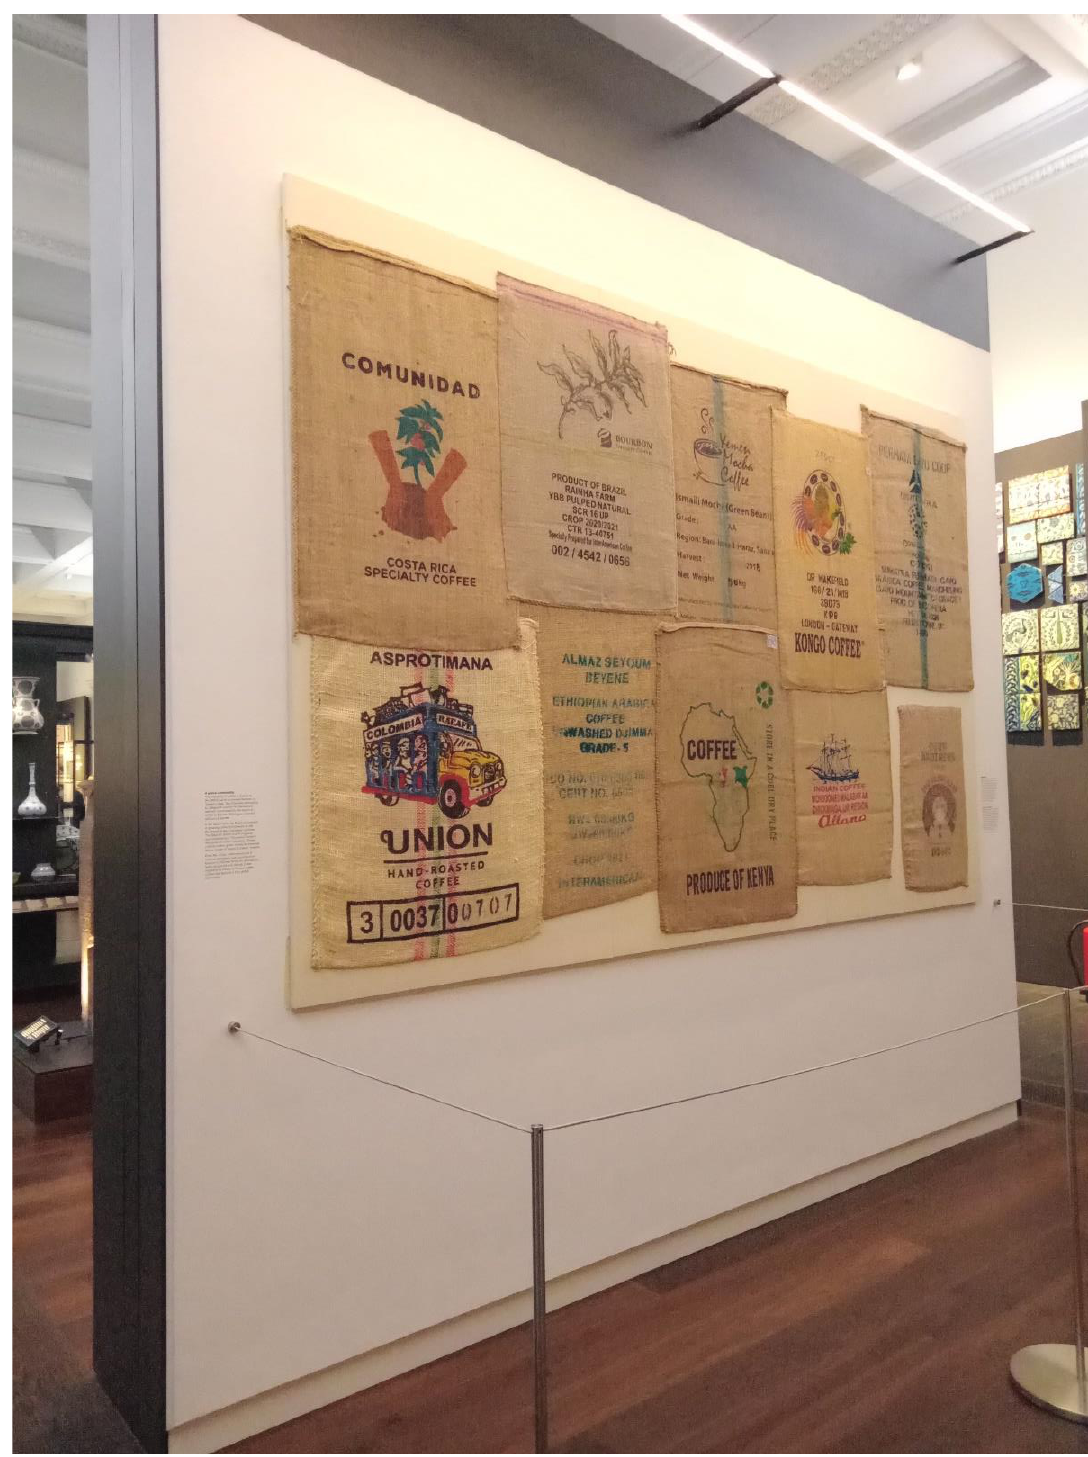
Figure 16. The coffee bags’ display. The Albukhary Gallery, British Museum. Photos of the author.